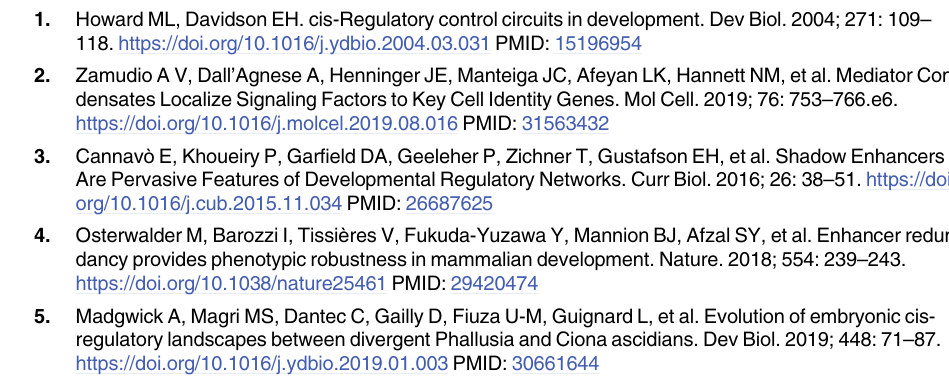
S2 Fig. AP and Primary/Secondary differences in reporter expression. A) Normalized reporter expression as a function of approximate anterior-posterior position in DMSO-treated control embryos. B) Normalized expression of the Proximal, Distal and Full Length reporter constructs at the indicated U0126 doses in primary notochord cells. C) Normalized expression of the Proximal, Distal and Full Length reporter constructs at the indicated U0126 doses in sec- ondary notochord cells. S1 Table. Full bootstrap parameter estimates for reporter dose-response curve